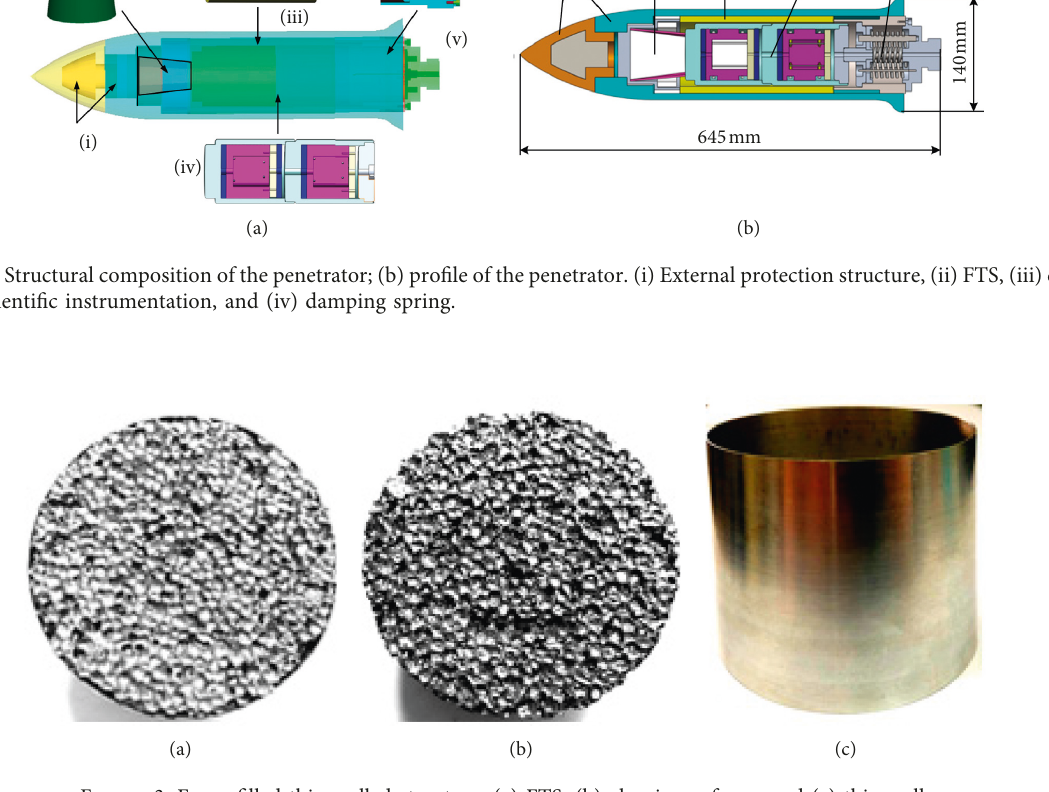
Figure 3: Foam-filled thin-walled structure. (a) FTS, (b) aluminum foam, and (c) thin